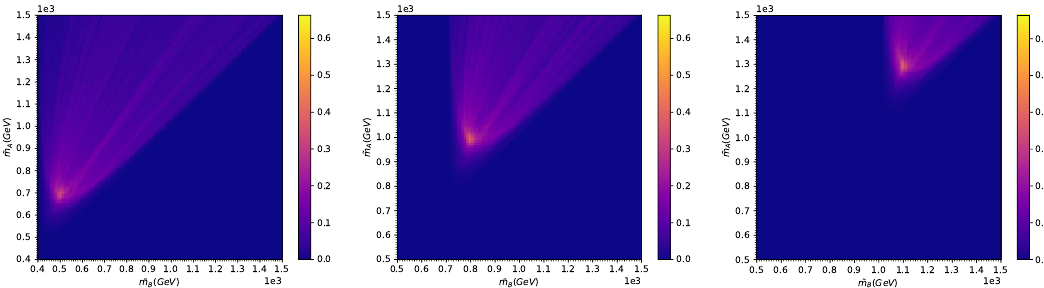
Figure 20 . The same as (cid:12)gures 16 and 18, but including the e(cid:11)ects of jet smearing. The left (middle, right) panel shows results for (cid:12)xed ~ m